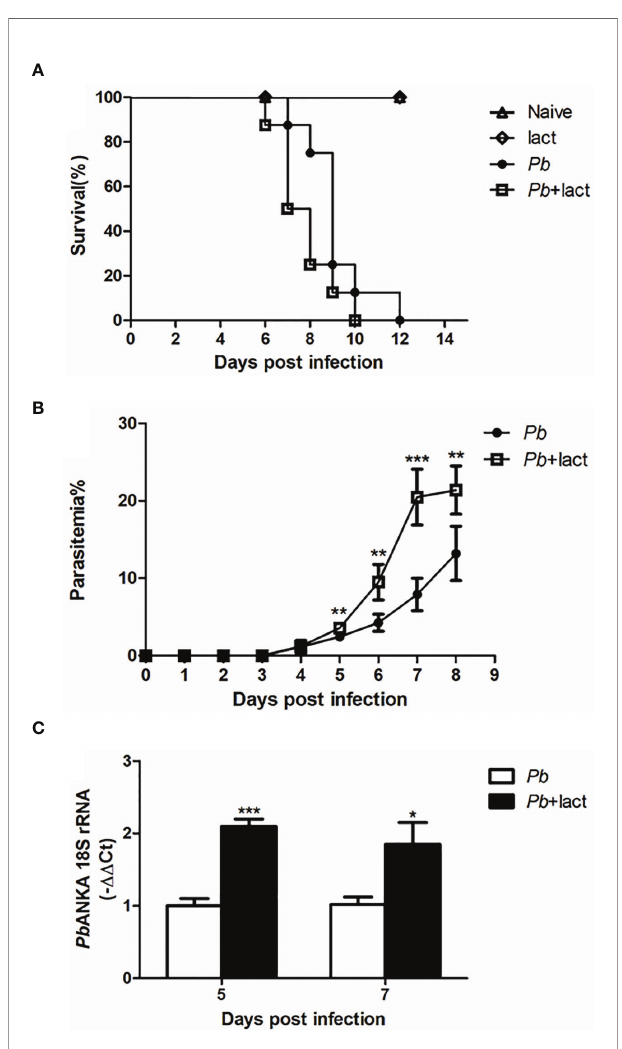
FIGURE 1 | Survival rate, peripheral bloodparasitemia, and liver parasite burden in Pb ANKA-infected mice with or without a -lactose treatment. (A) Survival rate. Malarial mice (n= 8)diedbetween days7 and 12 p.i. Malarial mice treated with a - lactose (n= 8) died between days 6 and 10 p.i. (B) Peripheral bloodparasitemia levelsofmalarial mice andmalarial mice treated with a -lactose were determined through blood smearsat the indicated timepoints. Parasitemia are shown as mean ± SD.** P < 0.01, malarialmice treated with a -lactose on days 5, 6, and 8 p.i. vs . malarial mice on days5, 6, and 8 p.i.; *** P < 0.001, malarial mice treated with a -lactose onday 7 p.i. vs . malarial mice on day 7 p.i.There were 4 mice per group, and data are representative of thosefromtwo experiments. (C) Parasite burden estimatedusing mRNA level of Pb ANKA 18S rRNA in the liverswas measured byusing qRT-PCR.Values are meansfromtriplicate measurements, anddata are shownas − DD Ct values. *** P < 0.001, malarial mice with a -lactose treatment onday 5 p.i. vs . malarial mice on day 5 p.i.; * P < 0.05, malarial mice with a -lactose treatment on day 7 p.i. vs . malarialmice onday 7 p.i.There were 4 mice per group, and data are representative ofthose from two